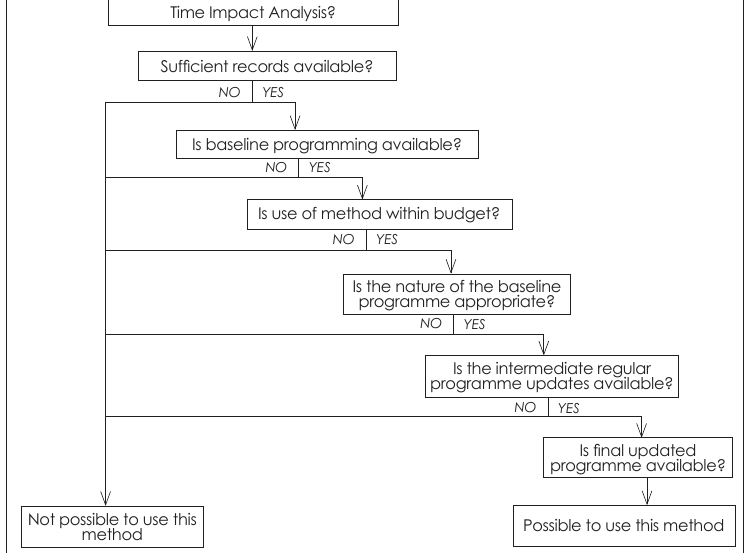
Figure 11: Decision tree: Use Time impact analysis? If a programme with a clear critical path is not available, one of the non-critical path methods should be considered. The project- related information available would be the most significant deciding factor utilised in the decision tree to choose the most appropriate non-critical path DAM. One of the following decision trees can be utilised to decide on the most appropriate non-critical path method (Figures